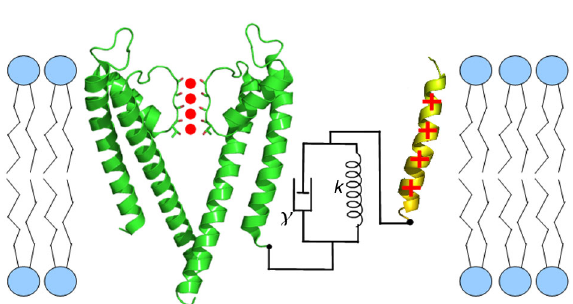
FIG. 14. Conceptual representation of the heuristic mechanical model we use to rationalize the measurements. The positively charged arginines move up and down in response to the electric field generated by the membrane polarization. They are coupled to the rest of the structure through complex interactions that we summarize into one effective mechanical element, a spring, and a dashpot. This mechanical element is nonlinear, with the nonlinearity built into the dissipation coefficient (cid:1) of the dash- pot, which transitions to higher values beyond a critical strain rate (cid:8) c (see Fig.